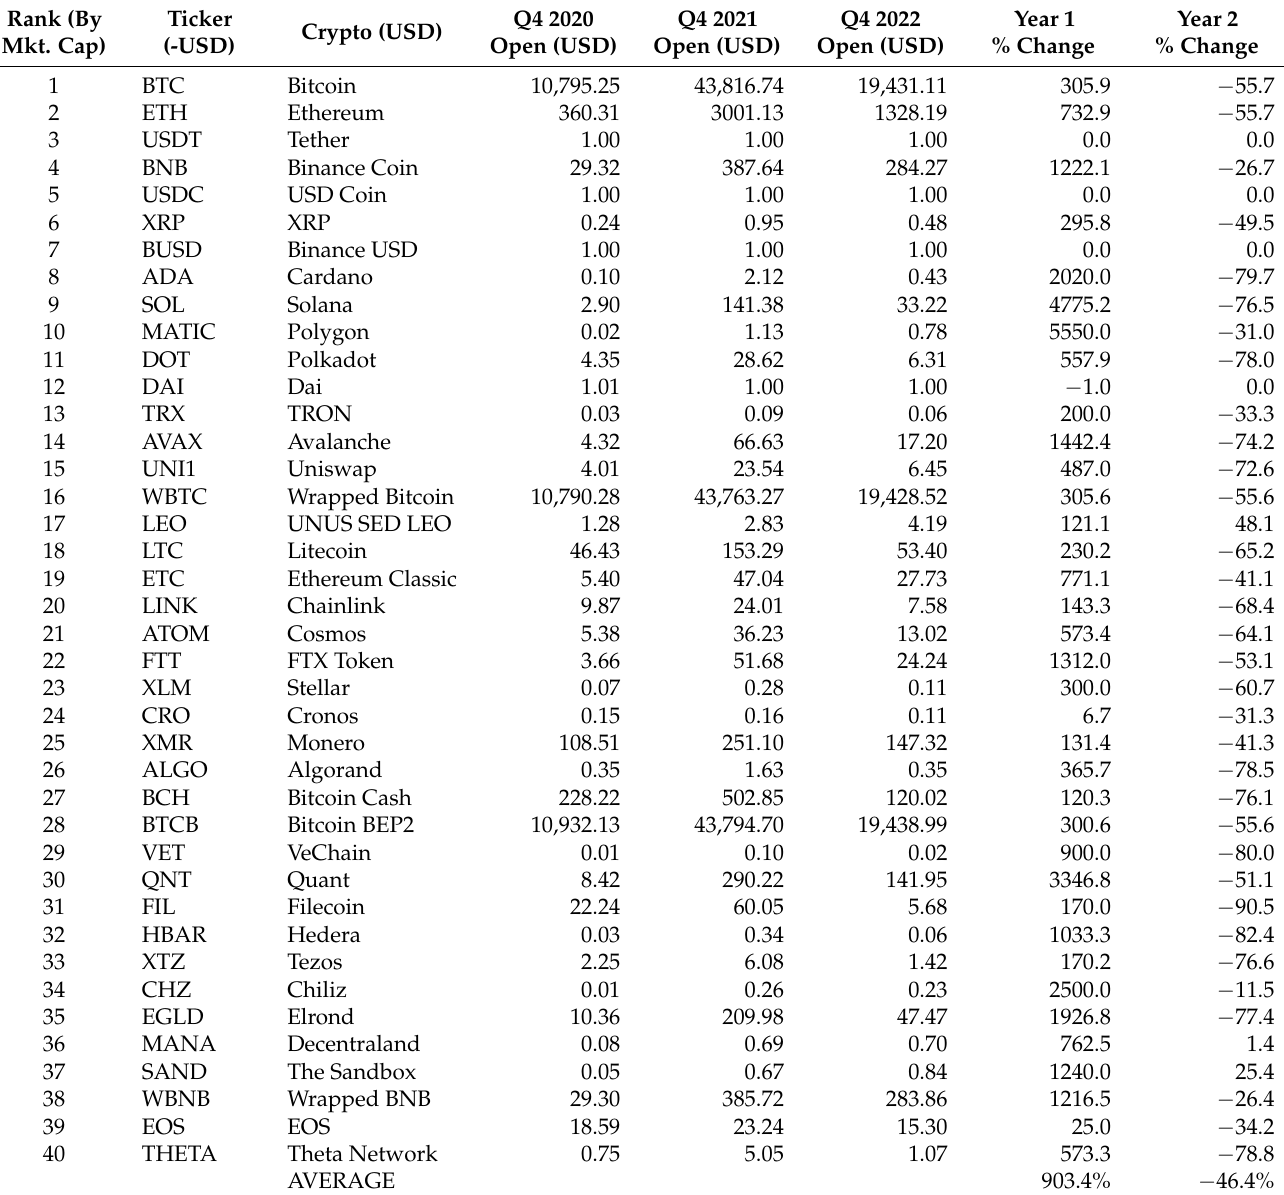
Table 2. Cryptocurrency